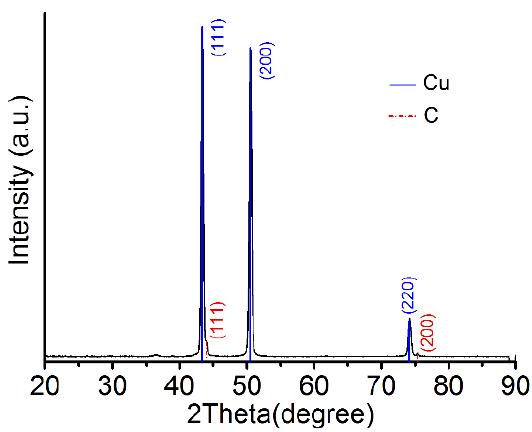
Figure 11. XRD spectra of the coating surface.